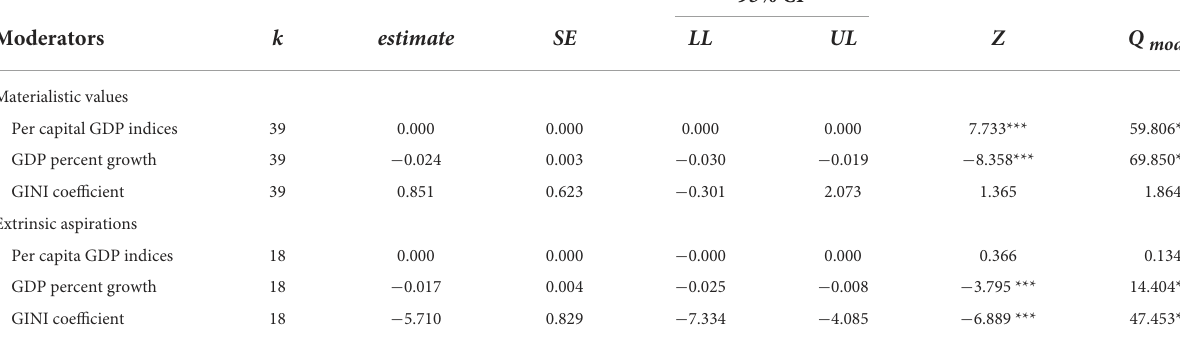
TABLE 7 Per capita GDP indices, GDP percent growth, and GINI coefficient as moderators